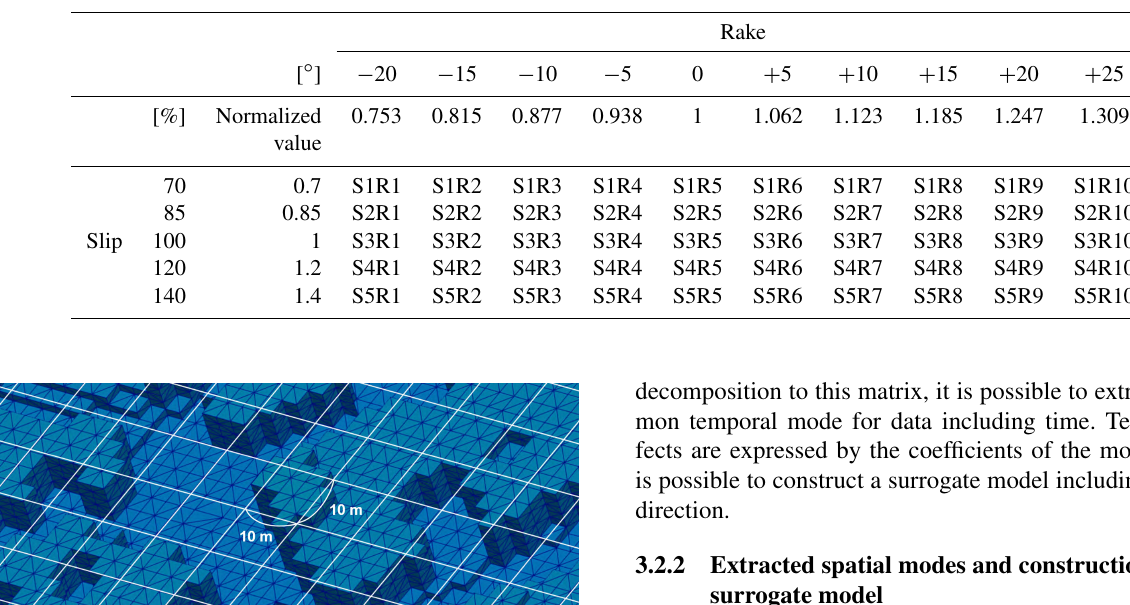
Table 1. Calculation cases.